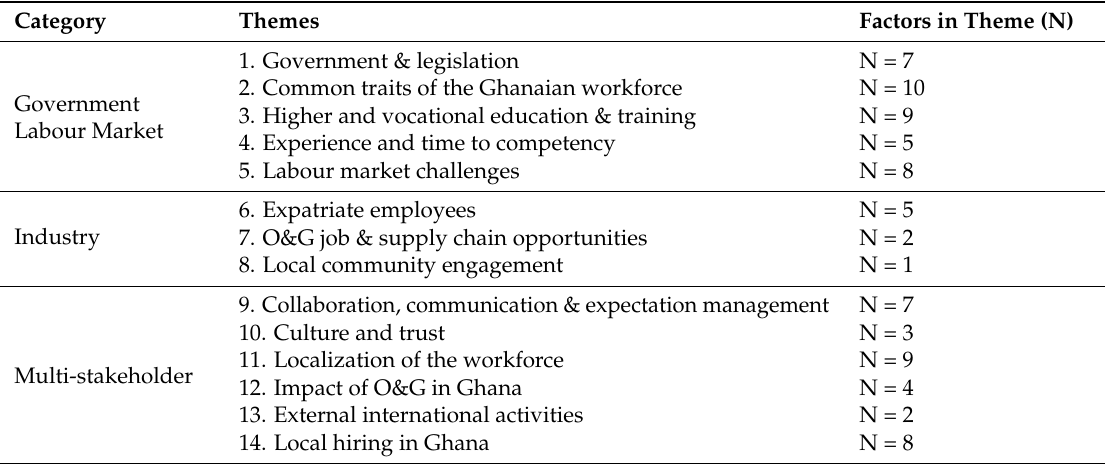
Table 2. Themes by category affecting job role localization in Ghana.